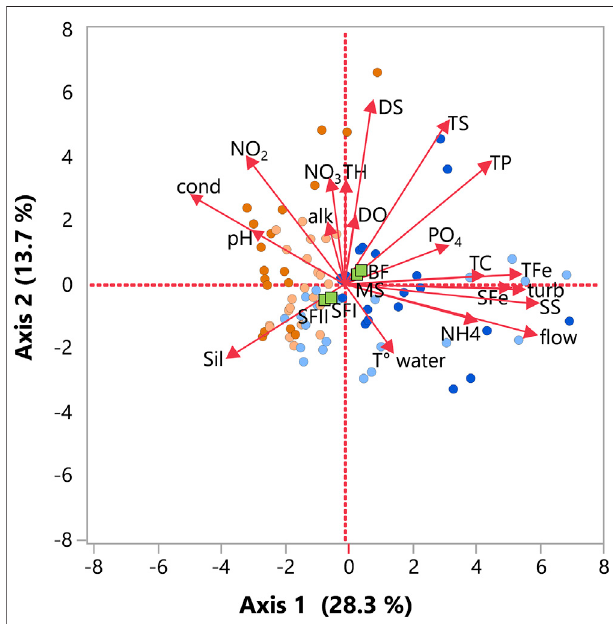
FIGURE 2 | Principal component analysis (PCA) applied to investigate the spatial and temporal variation of environmental variables in the three Small Hydroelectric Power Plant (SHP) reservoirs: Monte Serrat (MS), Bonfante (BF) and Santa Fé (SF I e II) along the Paraibuna River ( n = 96). The green squares represent the reservoirs and the colored dots represent the samples. The colors of the dots indicate the interannual periods, as follows: light blue = March, rainy season; dark blue = December, rainy season; light orange = June, dry season; dark orange = September, dry season. Variables are: T ° _water, water temperature; NH 4 , ammonium, SS, suspended solids; DS, dissolved solids; TS, total solids; SFe, soluble iron; TFe, total iron; turb,